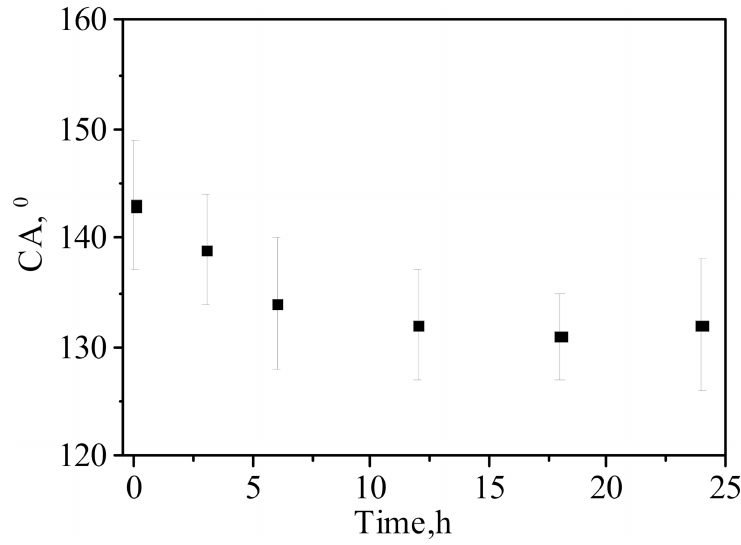
Figure 6. The change in CA of PET-Si-F membranes with pore diameter 152 nm after keeping in water at 75 ◦